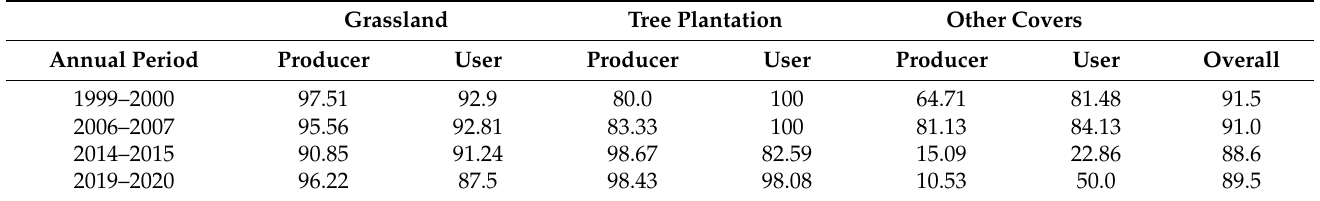
Table 2. Producer and user accuracy values for the land cover classes and overall accuracy values for each annual period under study. See Appendix C for a detailed analysis of the contingency